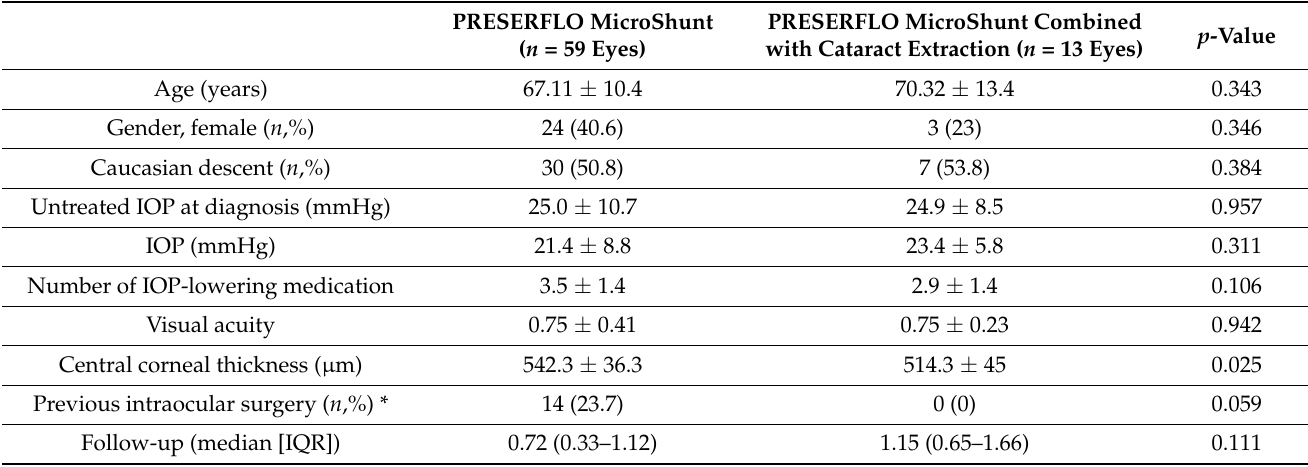
Table 1. Baseline preoperative characteristics of the population presented as the mean ± standard deviation unless stated otherwise. PRESERFLO MicroShunt ( n = 59